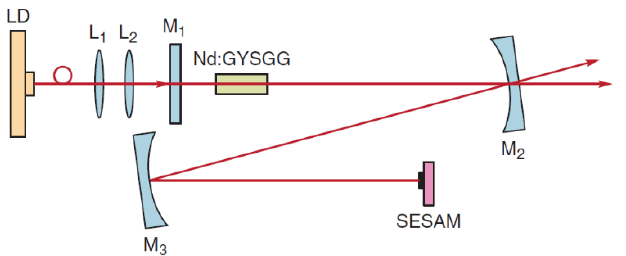
Figure 5. Schematic diagram of a mode-locking Nd:GYSGG laser [23]. SESAM: semiconductor saturable absorber mirror